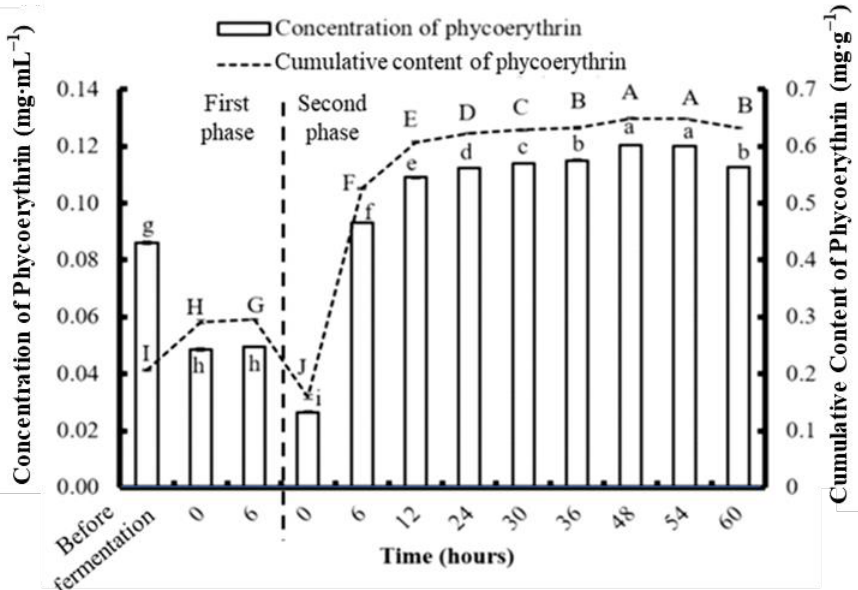
Figure 6. The effect of different fermentation times on the concentration and content of phycoerythrin in Colaconema formosanum before and during two-phase fermentation with Pseudoalteromonas haloplanktis , ATCC 14393. Lowercase letters (a, b, c . . . ): concentration of phycoerythrin between each fermentation time; uppercase letters (A, B, C . . . ): content of phycoerythrin between each fermentation time ( n = 3, Duncan’s test, p < 0.05).